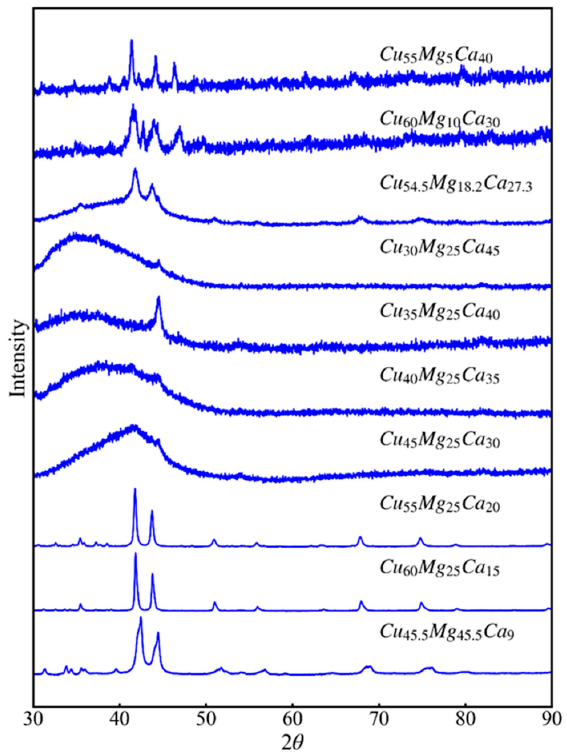
Figure 1. XRD spectra of the as-quenched ribbons of Cu-Mg-Ca alloys. The crystalline phases producing the Bragg reflections are discussed in the main text.